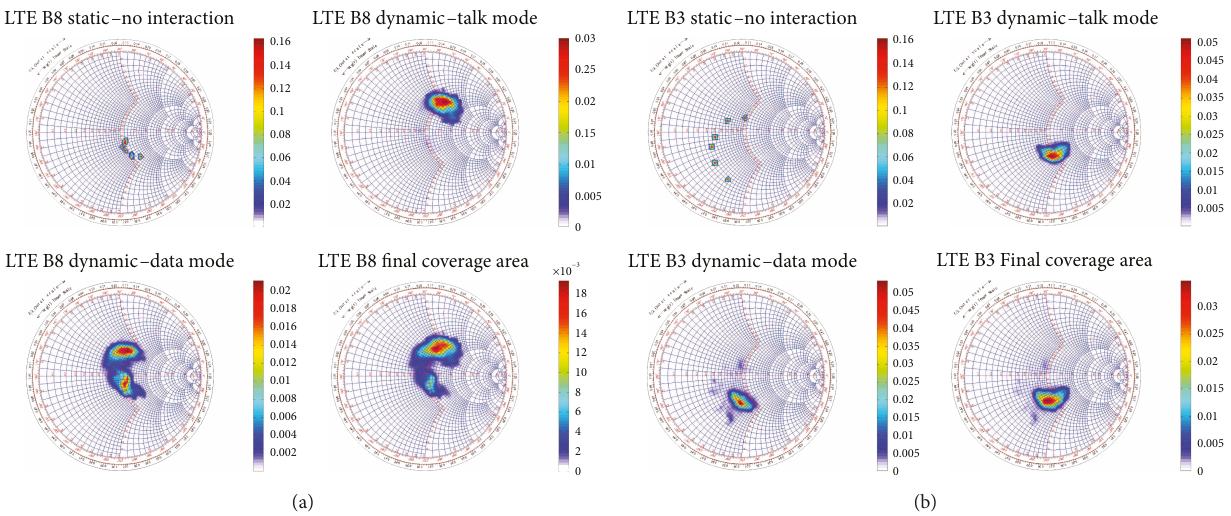
Figure 4: Experimental Smith chart representation of the re fl ection coe ffi cient samples for Descartes model. (a) UTRA/FDD LTE B8 band. (b) UTRA/FDD LTE B3